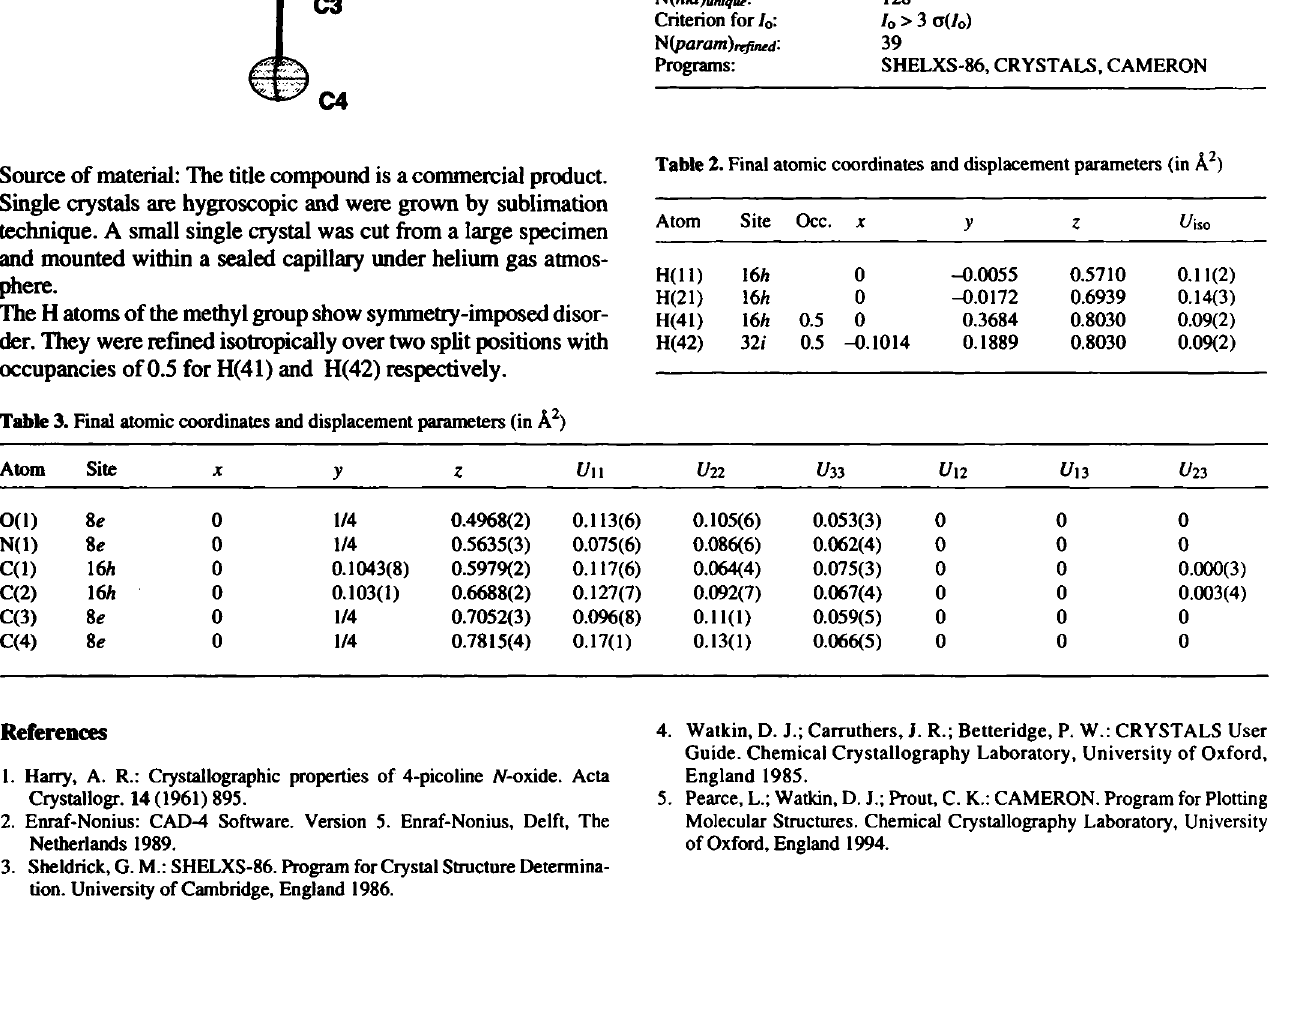
Table 2. Final atomic coordinates and displacement parameters (in